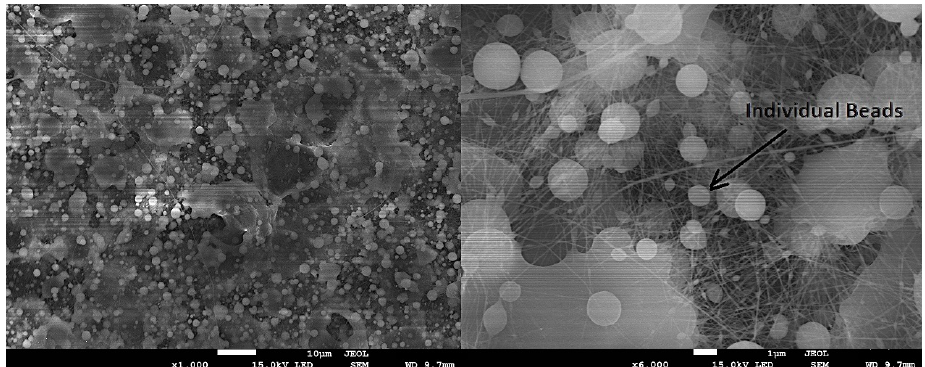
Figure 4. An example of individual beads textile resulting from polymerized electro-spun V 2 O 5 with PVP + Graphene Oxide diluted in water. Reprinted from ref.